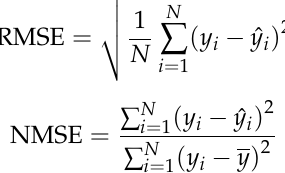
Figure 15. Estimated Heading (Yaw) depending on road surface condition: ( a ) Dry asphalt; ( b ) Gravel; ( c ) Wet; and ( d ) Snowy.